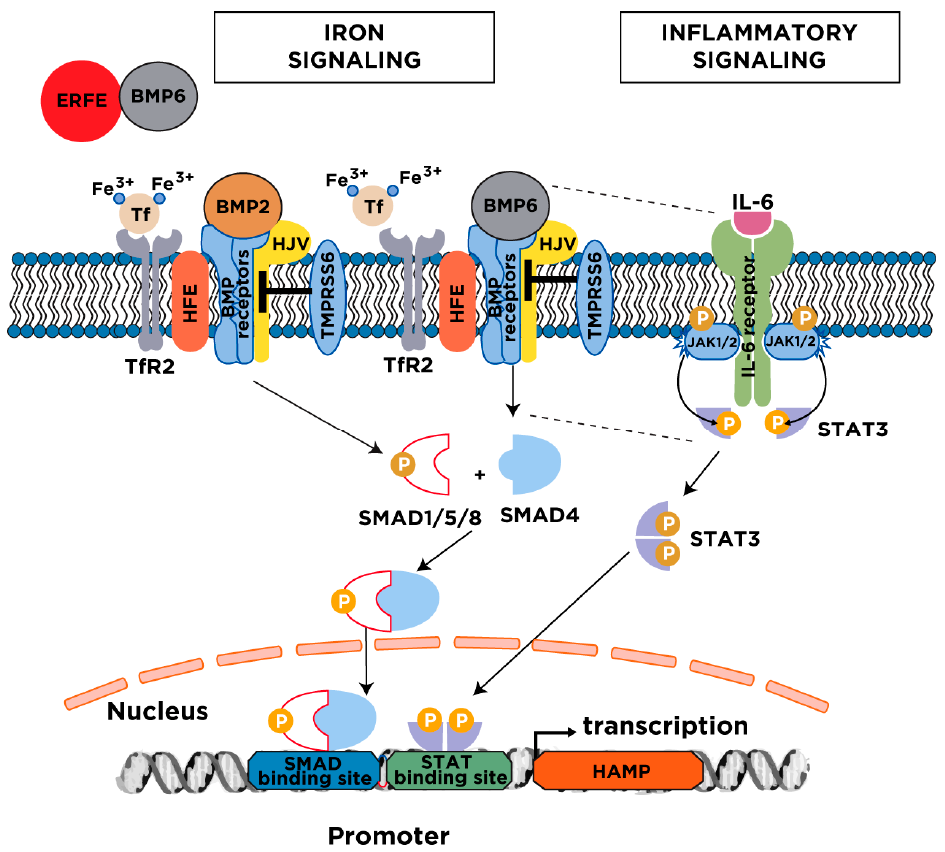
Figure 3. Major mechanisms for hepcidin regulation. Serum and tissue iron induce hepcidin transcription via the BMP/SMAD signaling pathway. The cascade is initiated following an increase in transferrin saturation and the secretion of BMP6 from liver sinusoidal endothelial cells; BMP2 is likewise secreted from liver sinusoidal endothelial cells but is less responsive to iron. Diferric transferrin binds to TfR2, while BMP6 and BMP2 bind to type I and II BMP receptors on hepatocytes. These events trigger phosphorylation of regulatory SMAD1/5/8, recruitment of SMAD4, and translocation of the SMAD complex to the nucleus for activating hepcidin transcription upon binding to BMP response elements in the HAMP promoter. Efficient iron signaling to hepcidin requires the BMP co-receptor HJV and the hemochromatosis protein HFE, and is negatively regulated by the transmembrane serine protease matriptase-2 (TMPRSS6). Under conditions of high iron demand for erythropoiesis, the erythropoietic regulator erythroferrone (ERFE) is released from bone marrow erythroblasts and suppresses hepcidin by sequestering BMP6. The inflammatory cytokine IL-6 induces hepcidin transcription via the JAK/STAT3 signaling pathway. The binding of IL-6 triggers dimerization of IL-6 receptors on hepatocytes, which leads to activation of associated JAK1/2 and subsequent phosphorylation of STAT3. Phospho-STAT3 dimerizes and translocates to the nucleus, where it activates hepcidin transcription upon binding to a STAT binding site in the HAMP promoter. Efficient hepcidin induction by the inflammatory pathway requires a threshold of BMP6/SMAD signaling (indicated by the dotted lines). BMP, Bone Morphogenetic Protein; SMAD, Small Mothers Against Decapentaplegic; HFE, high iron (Fe); HJV, hemojuvelin; TfR2, transferrin receptor 2; JAK, Janus kinase; STAT, Signal Transducer and Activator of